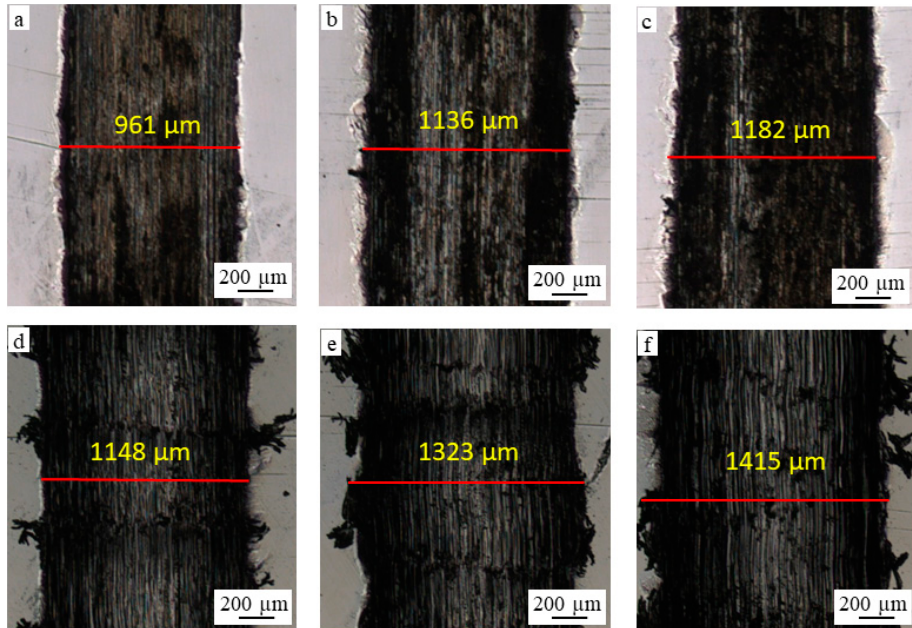
Figure 9. The wear scars under different loads with ( a ) 15 N, ( b ) 20 N and ( c ) 25 N; ( a – c ) is the images of coating A; ( d – f ) are the images of coating B.